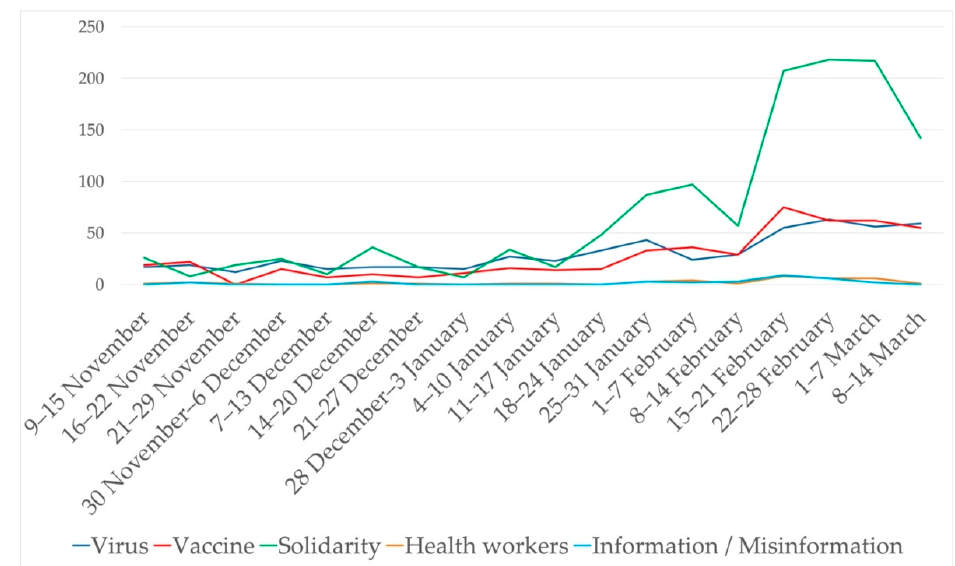
Figure 6. Evolution of themes in the messages.